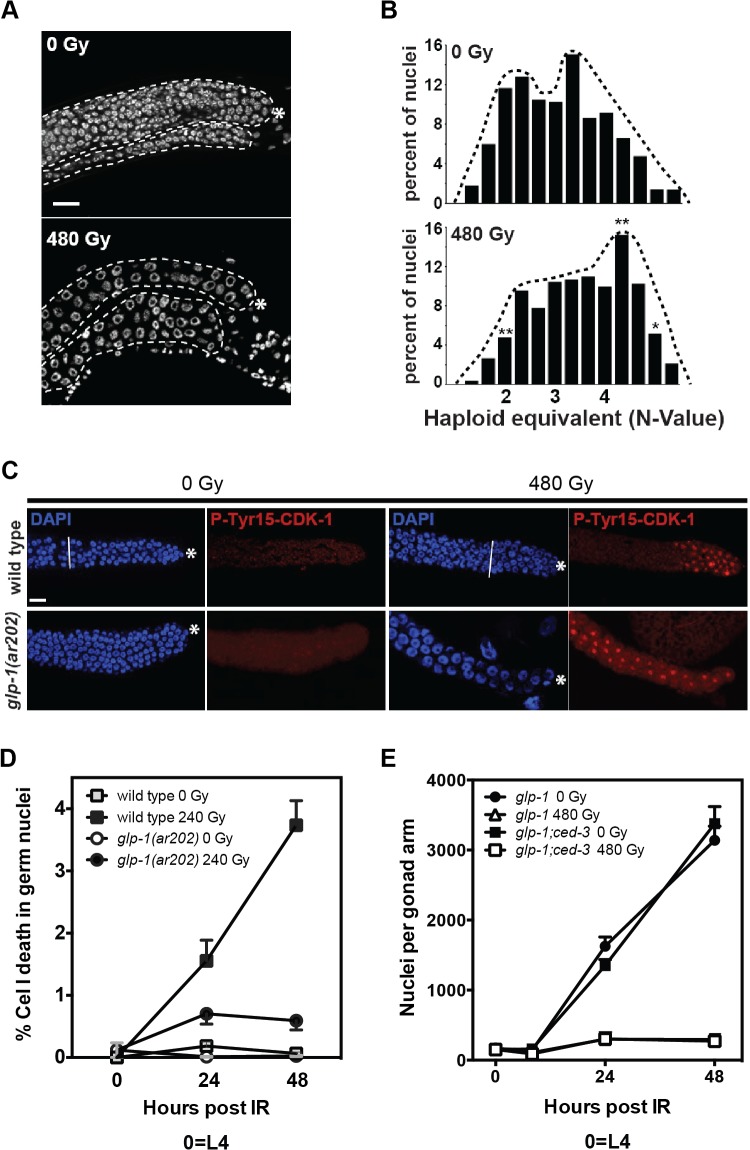
Tumor cells in glp-1(ar202) arrest in G2 phase following radiation exposure, and are apoptosis resistant.(A) Worms were irradiated at L4 stage and after 12h stained with DAPI. Representative germline tumors are outlined. (B) Relative nuclear DNA content of distal germ nuclei in unirradiated (0Gy) or irradiated (480Gy) worms. A total of 207 nuclei from 5 unirradiated worms, and 147 nuclei from 5 irradiated worms were scored. (*p<0.05; **p<0.01 relative to non-irradiated control). (C) Wild-type and glp-1(ar202) unirradiated or irradiated germline are stained with anti-phospho-Tyr15-CDK-1 antiserum (red) and DAPI (blue) as in Methods. White bar indicates border of proliferative zone. Asterisk indicates position of distal end. Scale bar is 20 μm. (D) Comparison of radiation-induced germ cell apoptosis in wild type and glp(ar202). Wild type and mutant worms were synchronized at 25°C and irradiated with 240Gy at the L4 stage. Germline apoptosis was scored in one gonad loop per worm. Incidence of germ cell death was quantified by dividing number of apoptotic germ cells by total germ cells. Data (mean±s.e.m) are from 10–12 worms⁄group. (E) Inactivation of apoptosis does not alter ar202 response to radiation. glp-1(ar202) and glp-1(ar202);ced-3(n717) double mutant worms were irradiated at the L4 stage. Data (mean±s.e.m) are from 9–12 worms⁄group. Note the line of “glp-1 480Gy” is hidden behind the line of “glp-1;ced-3 480Gy”.